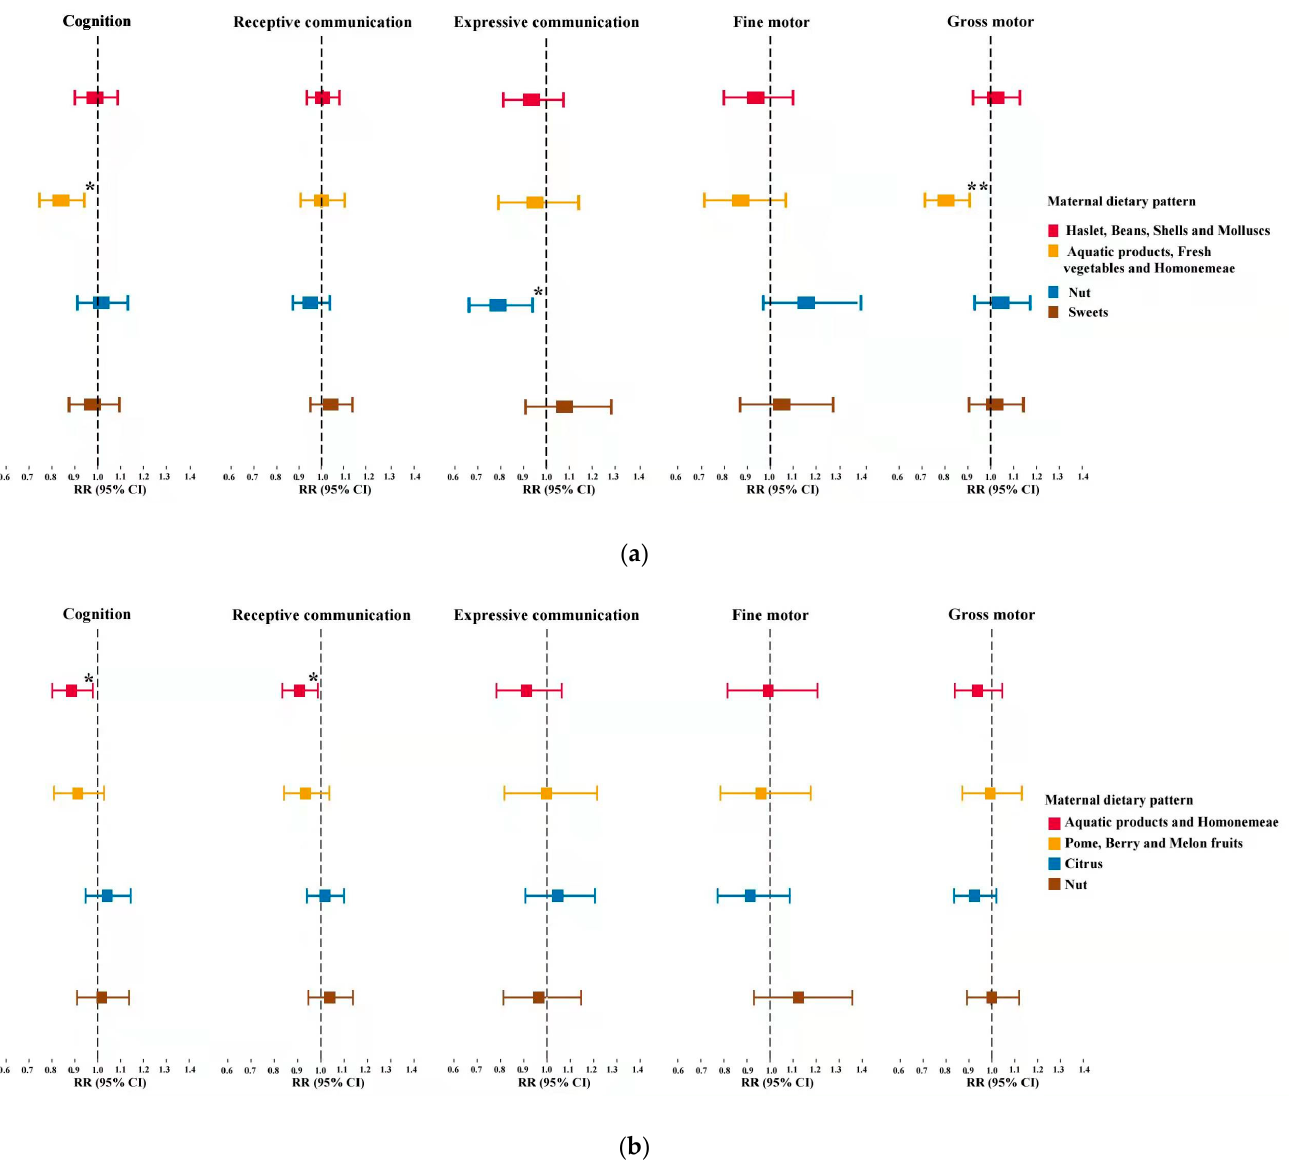
Figure 2. Adjusted associations of dietary patterns in the second and third trimesters with categor- ical outcomes of neurodevelopment in infants, respectively. Analyses were adjusted for mode of conception, maternal age, maternal pre-pregnancy body mass index (BMI), parity, hypertension, diabetes, gestational week at delivery, infant sex, duration of breastfeeding, principal component score of maternal dietary intake, folic acid supplements. * p < 0.05, ** p < 0.001. ( a ), Second trimester; ( b ), Third trimester. Abbreviations: RR = Risk ratio; 95% CI = 95% confidence intervals. Table 2. Multivariable associations of adherence to the ‘Aquatic products and Homonemeae’ pattern in the second and third trimesters and categorical outcomes of neurodevelopment in infants. Receptive Expressive Cognition Fine Motor Gross Communication Communication